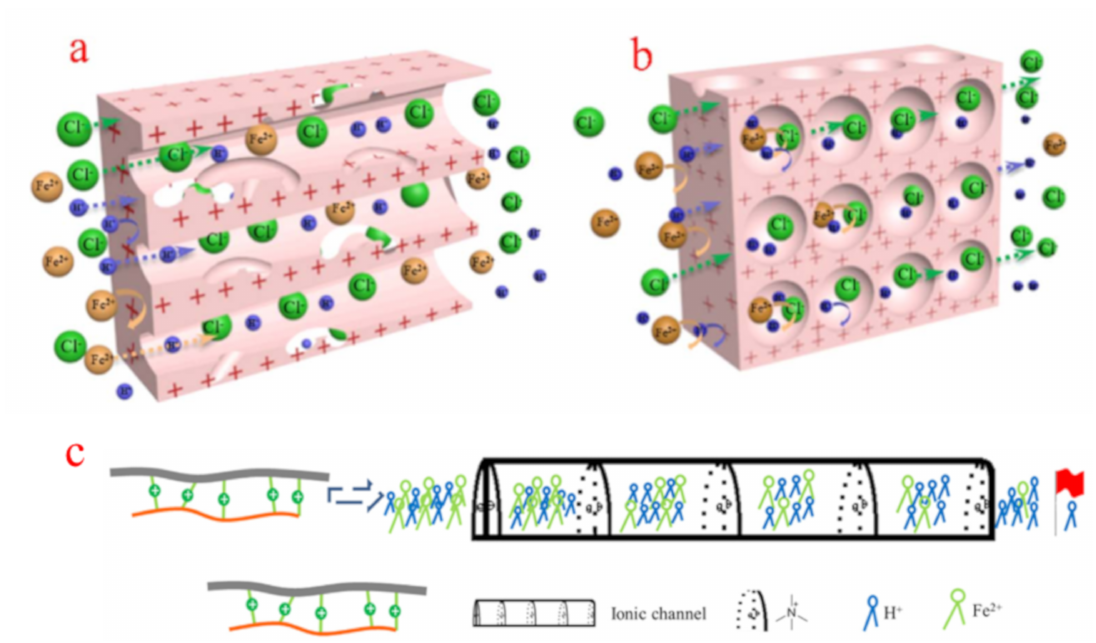
Figure 6. Plausible physical model of ions transferred in the finger-like ( a ) sponge-like structures during the DD process ( b ) and the separation of H + and Fe 2 + through the quaternary ammonium groups-based ionic channel ( c )